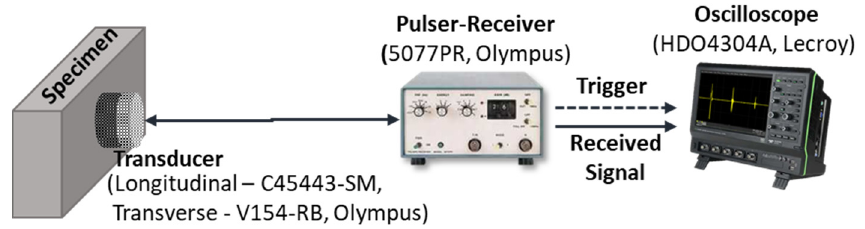
Figure 4. Experimental setup for measuring the velocities of longitudinal and transverse waves.